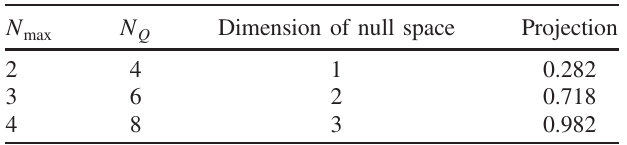
TABLE I. Degree to which numerical Q lies in null space of analytic Q ’ s for a c ¼ 7200 , N ¼ L ¼ 8